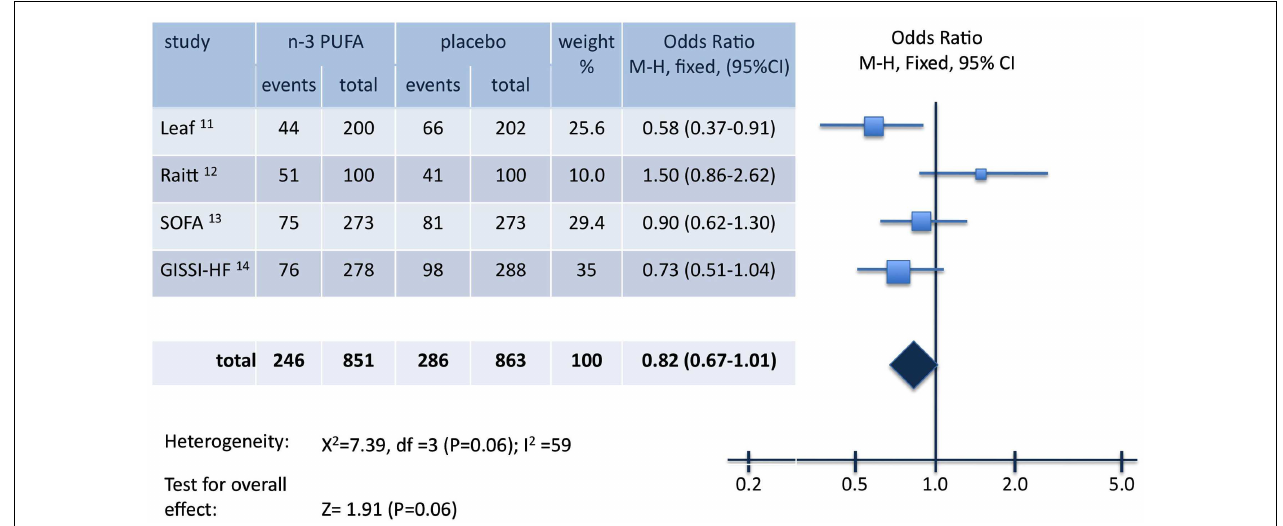
FIGURE 1 | Pooled analysis of the effect of n-3 PUFA on appropriate ICD